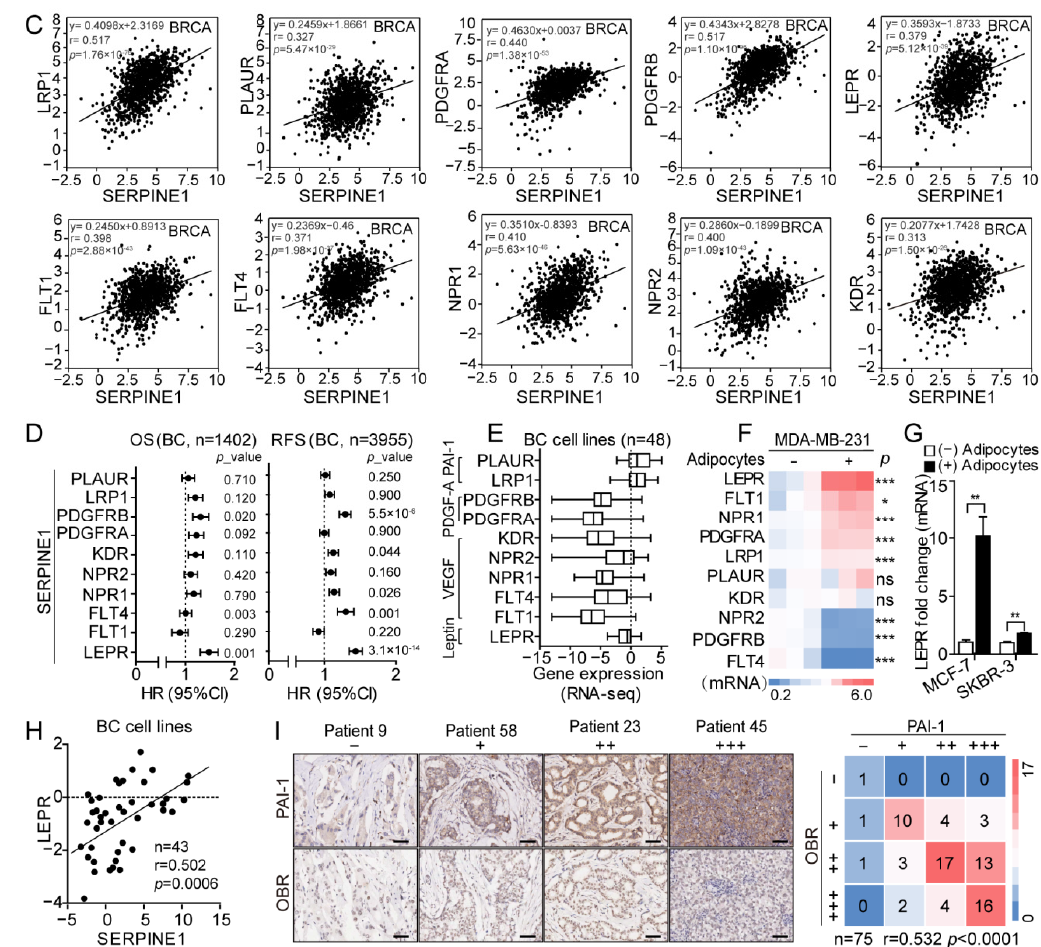
Figure 5. Activation of OBR is associated with adipocyte-induced PAI-1 expression. ( A ) The indicated cancer cells were treated with CM from cancer cells or adipocytes under monoculture or coculture conditions for 72 h, and western blot analysis was performed for PAI-1 expression ( n = 3 independent experiments). ( B – C ) Analysis of cytokine protein arrays. Among all the detected factors, 15 adipokines were initially identified as fold change ≥ 2.0 or ≤ 0.5 in CM of cocultured groups compared with that of adipocyte groups. Based on the correlation (r > 0.3) between PAI-1 and receptors of the 15 adipokines in breast cancer via TCGA dataset, 10 receptors and their counterpart adipokines including VEGF, leptin,